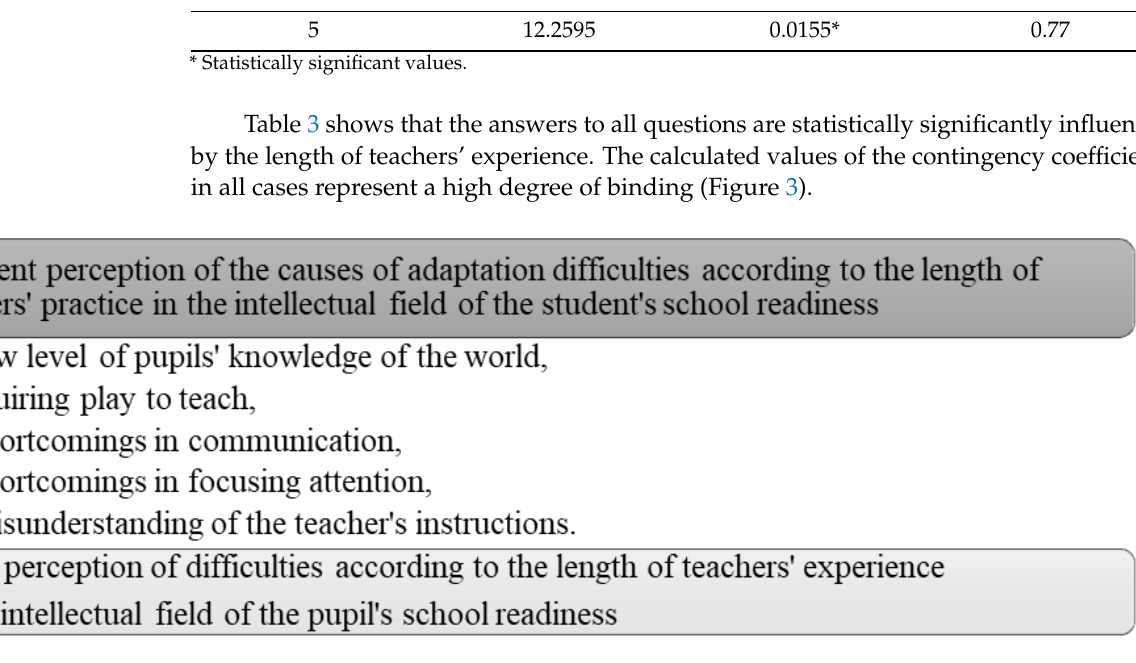
Figure 3. Perception of the causes of intellectual adaptation difficulties.